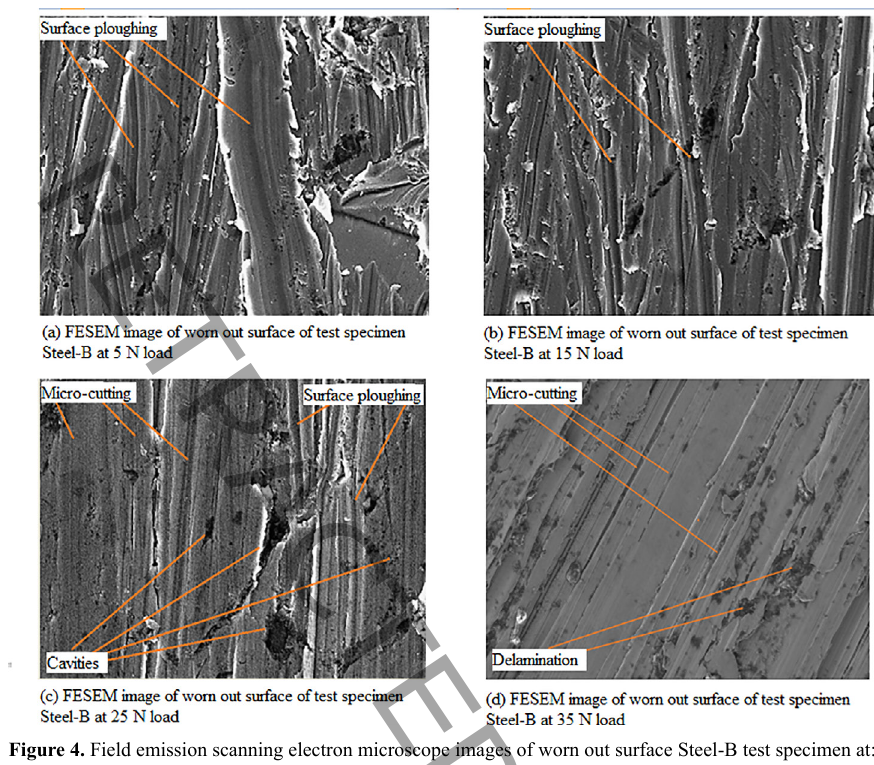
Figure 4. Field emission scanning electron microscope images of worn out surface Steel-B test specimen at: (a) 5 N, (b) 15 N, (c) 25 N and (d) 35 N.